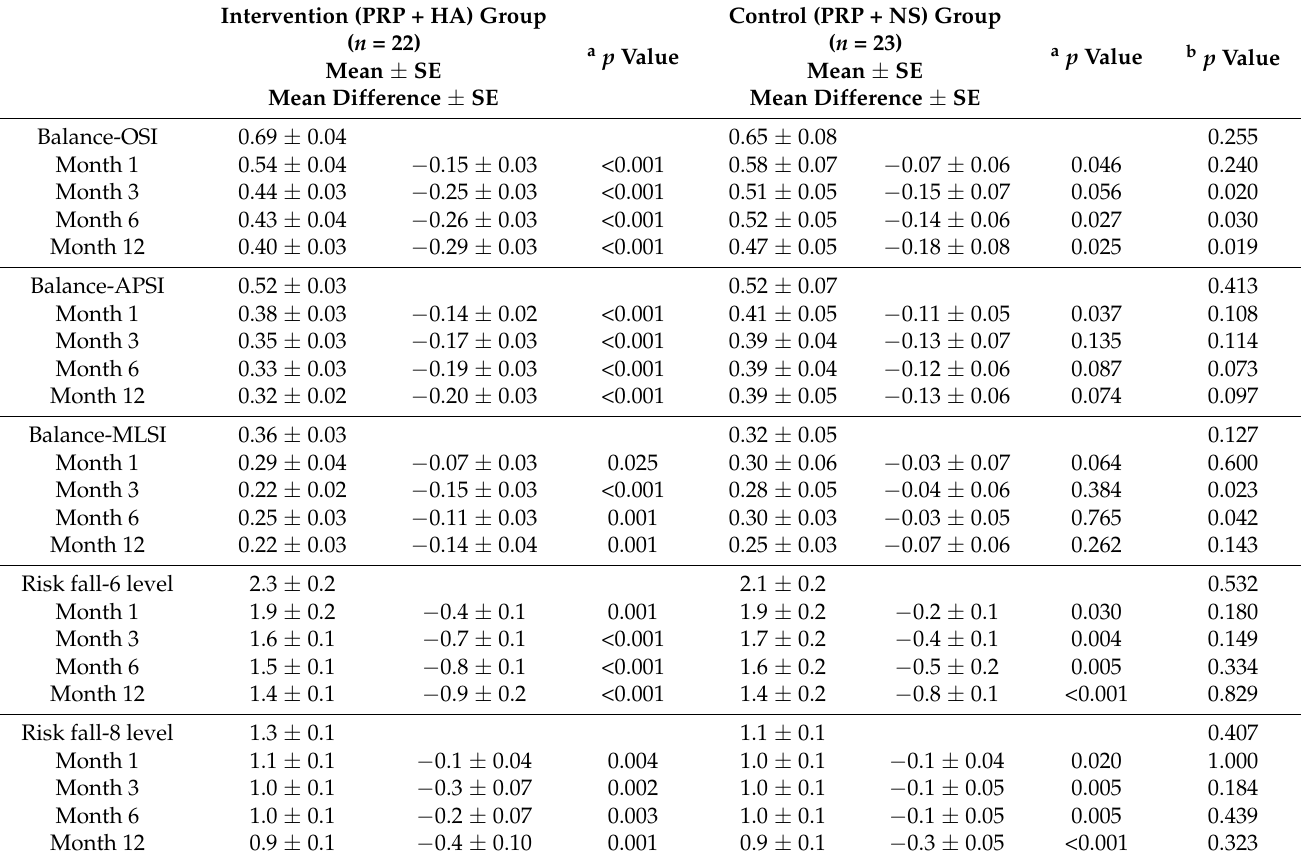
Table 4. Comparison of all balance and risk of fall analyses between both